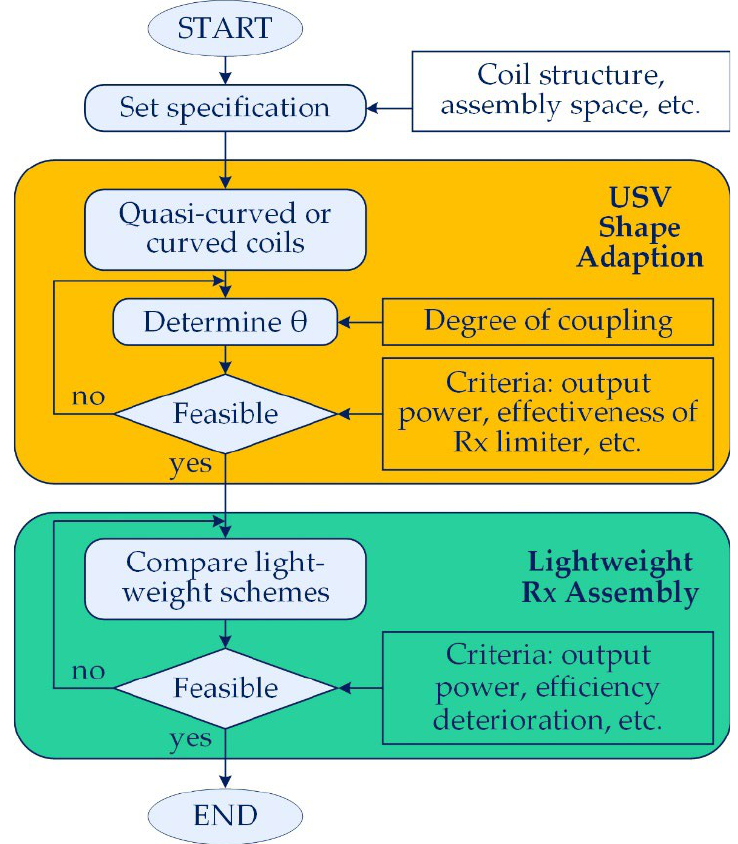
Figure 10. A flowchart of optimization process.